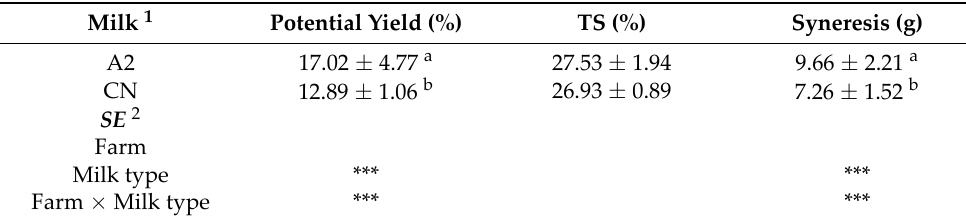
Table 7. Potential yield, total solids and syneresis of A2 and control milks. Milk